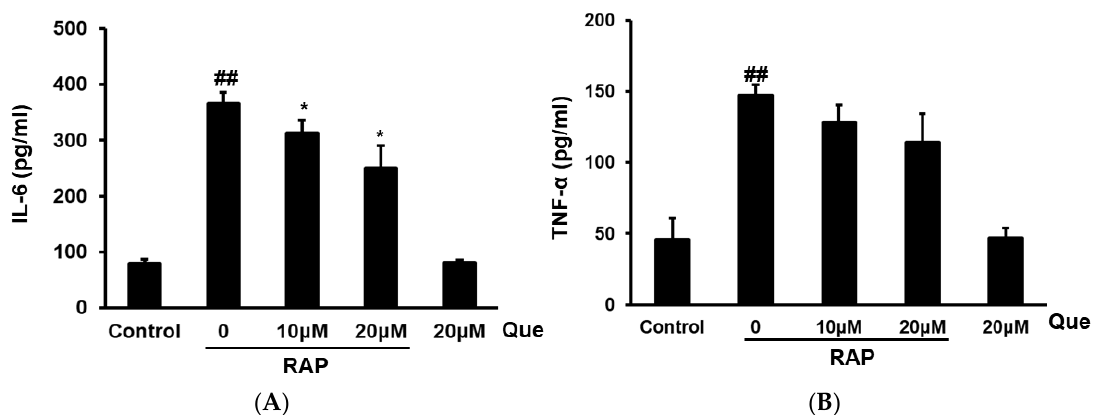
Figure 4. Effects of quercetin on IL-6 ( A ) and TNF- α ( B ) production in RAP-induced peritoneal macrophages. Peritoneal macrophages cells were incubated with quercetin (10, 20 μ M) and then treated with RAP (100 μ g/mL) for 24 h. Data from the experiments are expressed as mean ± SD (## p < 0.01 compared with control group; * p < 0.05, ** p < 0.01 compared with RAP group).